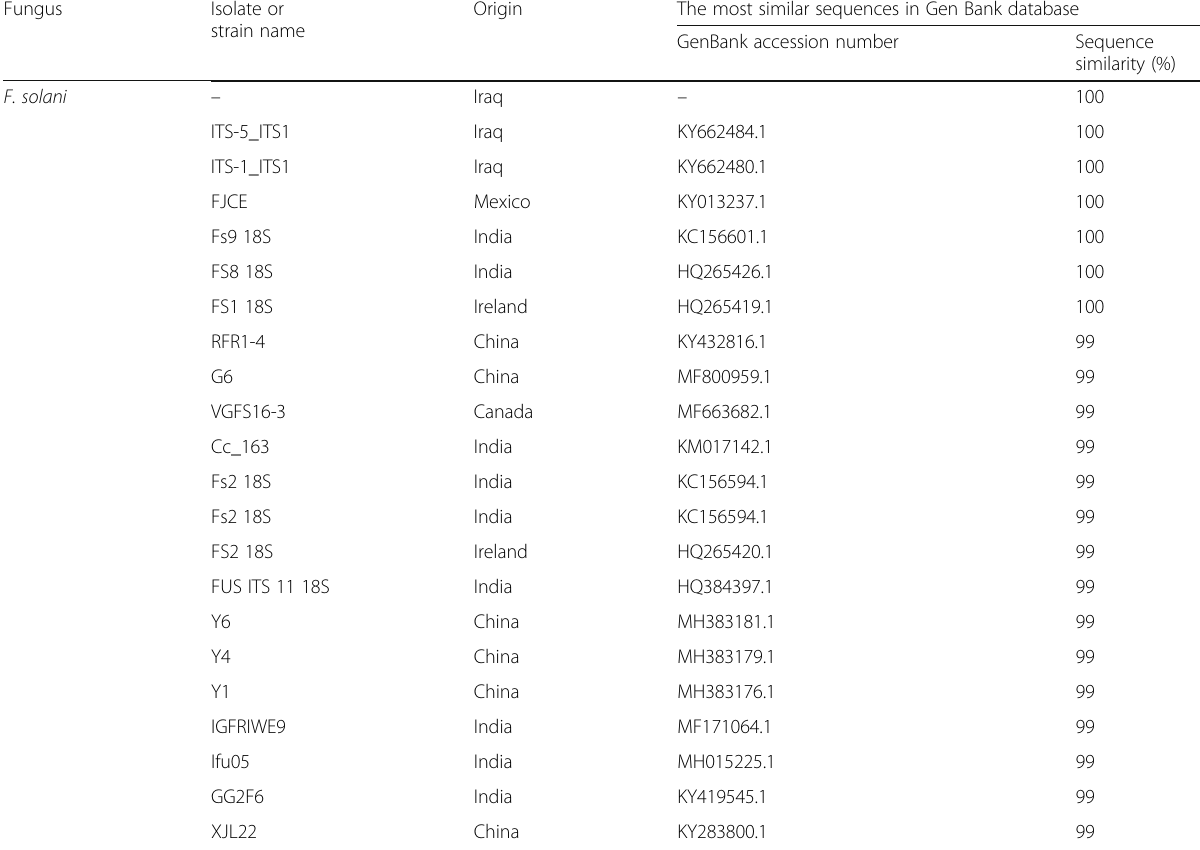
Table 1 Comparison of the generated sequence of the Iraqi F. solani , isolated from diseased cucumber roots, with those of F. solani isolates available in GenBank